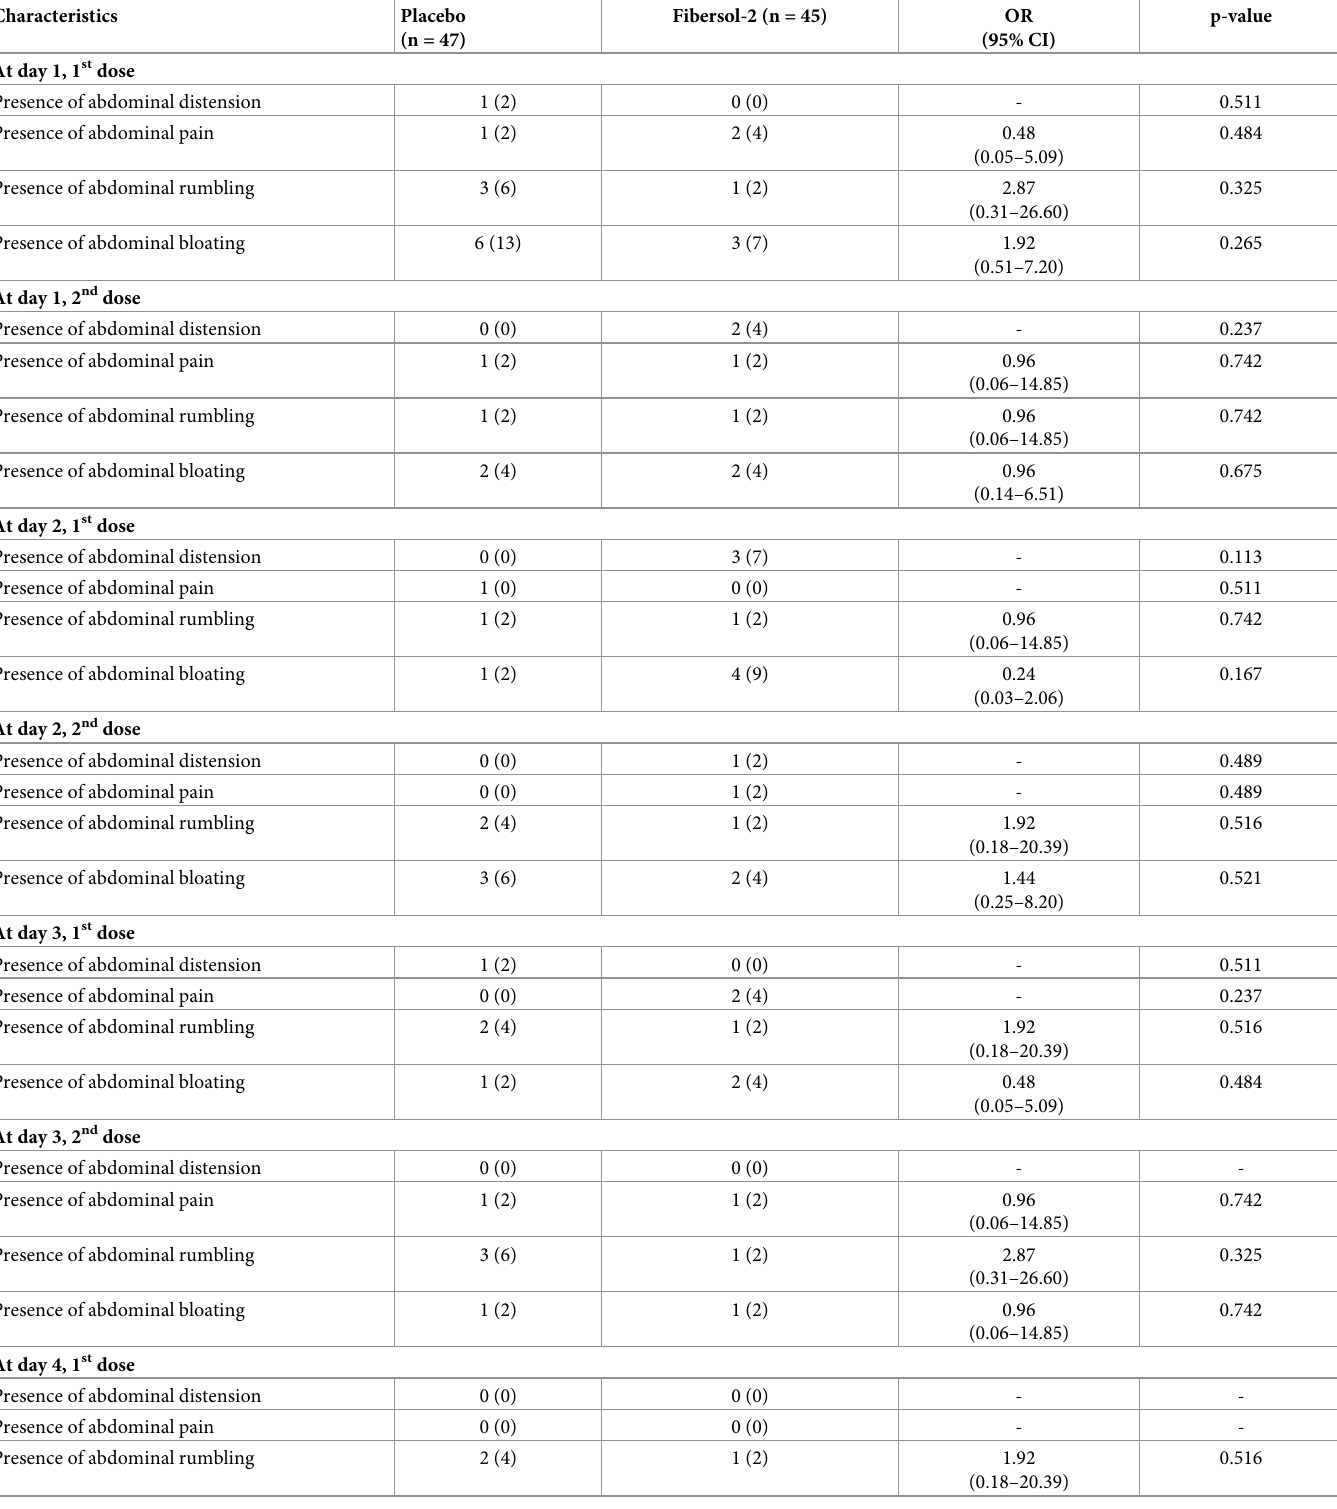
Table 5. Characteristics of gastrointestinal symptoms after ingestion of study drugs during the intervention period in both the groups.